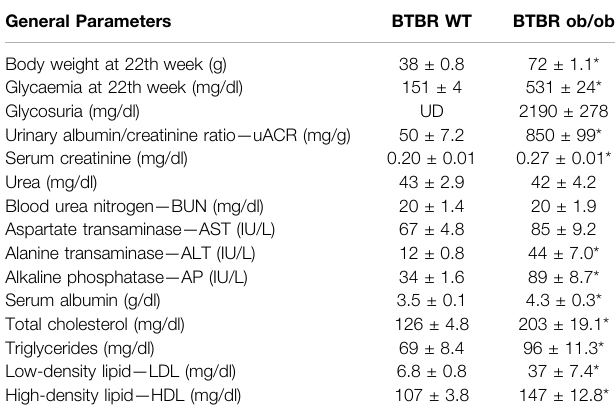
TABLE 1 | Metabolic and renal parameters in BTBR WT and BTBR ob/ob mice. * p < 0.05 vs . BTBR WT; UD, undetectable. General